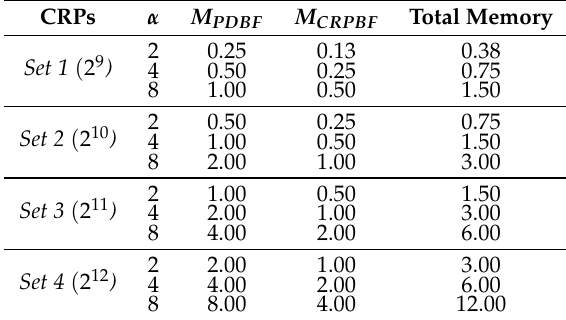
Table 1. Memory requirement of total Bloom filter (KB).